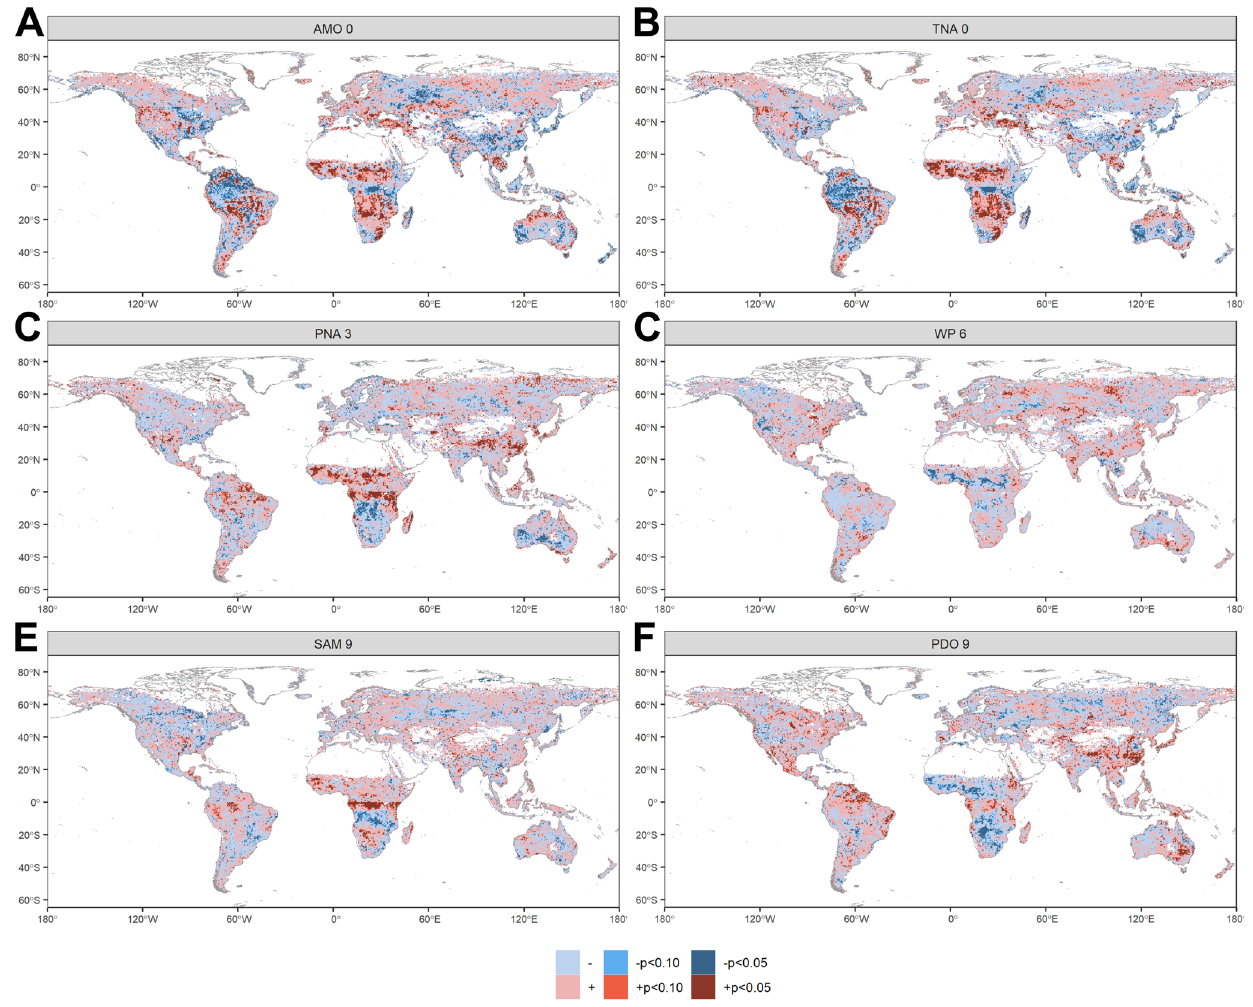
Fig. 2 | Synchronous (0-month lag) and lagged (3, 6 and 9 months) Pearson R correlationbetweenclimateteleconnections(CT)andburnedarea(BA)during the fi re season peak from 1982 to 2018. The maps at 0.5°x 0.5° pixel resolution represent the correlations at P <0.05 (|R|>=0.34) and P <0.10 (|R|>=0.29) betweenBAand CTs.The six most important CTsinterms of modulated globalBA